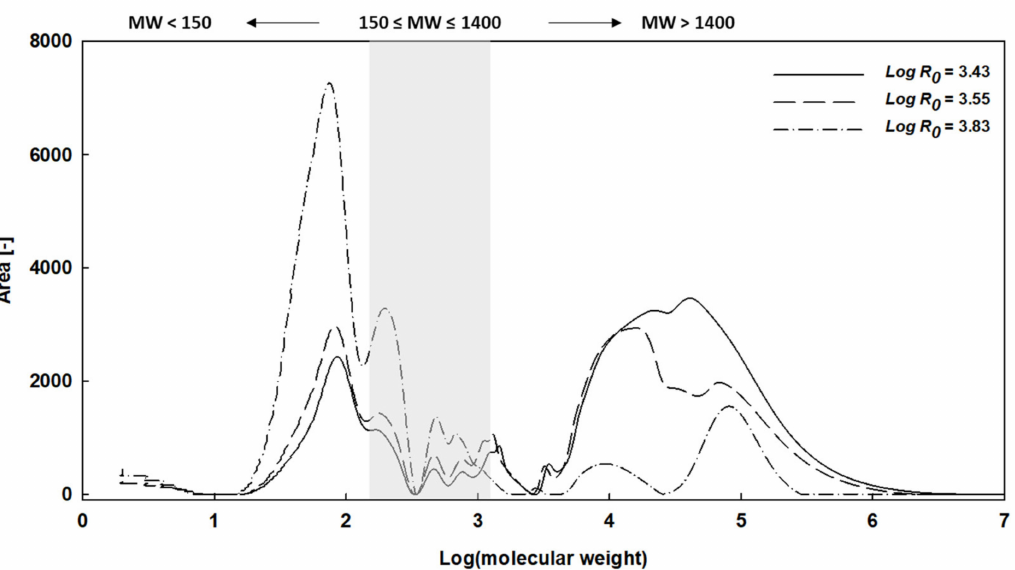
Figure 7. Molecular weight distribution of CM-HW-treated hydrolysate for reaction severity ( Log R 0 ) at 3.43, 3.55, and